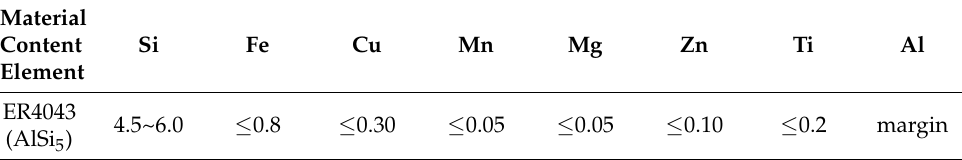
Table 3. Main chemical composition of ER4043 welding wire (%)